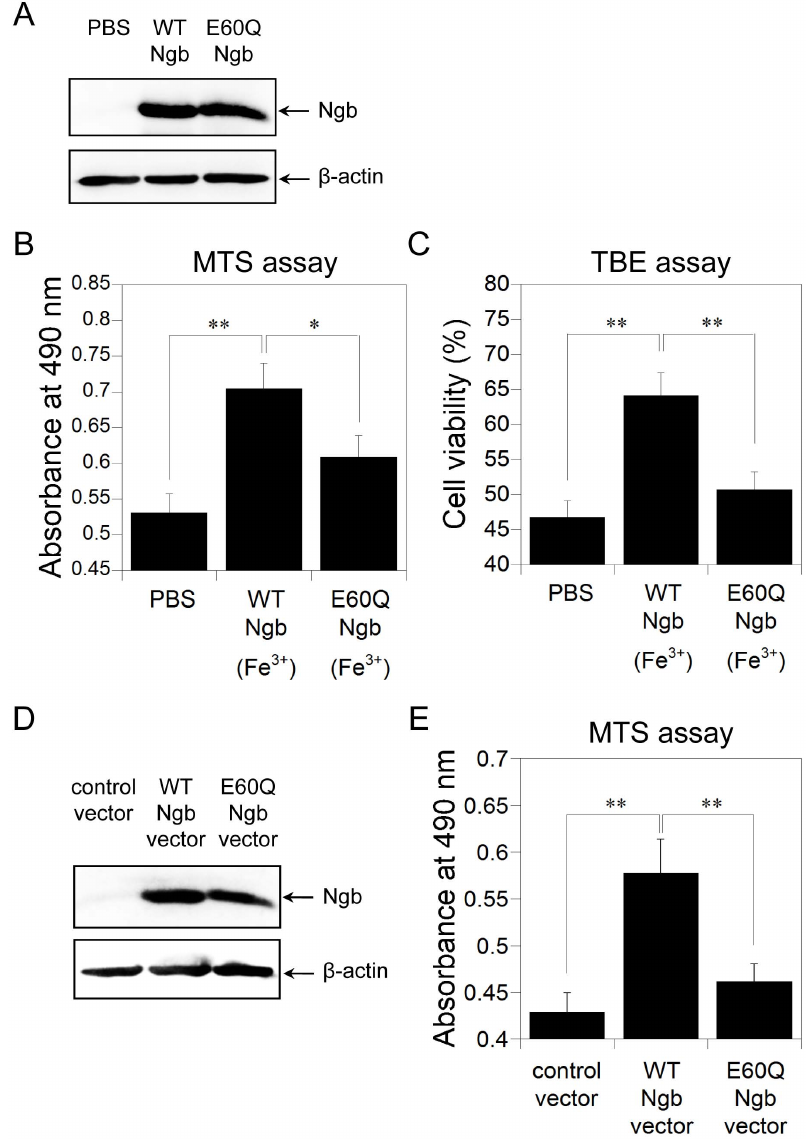
Figure 4. Effects of human WT Ngb or E60Q Ngb on neuroprotective activities. (A) Western blot analyses of SH-SY5Y cell lysates after protein transduction. PBS, human WT Ngb or human E60Q Ngb was applied to differentiated SH-SY5Y cells with Chariot. The cells were then incubated for 3 h. Cell lysates were analyzed on 15.0% or 12.5% SDS/PAGE and by Western blot analyses using rabbit anti-Ngb polyclonal antibody or mouse anti- b -actin monoclonal antibody, respectively. (B,C) Effect of the E60Q mutation in human Ngb on SH-SY5Y cell death caused by the in vitro OGD model of ischemia. Human WT or E60Q Ngb was transfected into differentiated cells using Chariot. Following OGD/recovery, cell viability was measured by MTS (B) and TBE assays (C). All data are expressed as means 6 SEM from three independent experiments, each performed in triplicate. Data were analyzed by one-way ANOVA followed by Tukey-Kramer post hoc tests. *P , 0.05, **P , 0.01. (D) Western blot analyses of SH-SY5Y cell lysates after transfection. Control vector, human WT or E60Q Ngb expression vector was transfected into differentiated SH-SY5Y cells with Lipofectamine. The cells were then incubated for 24 h. Cell lysates were analyzed on 15.0% or 12.5% SDS/PAGE and by Western blot analyses using rabbit anti-Ngb polyclonal antibody or mouse anti- b -actin monoclonal antibody, respectively. (E) Effect of the E60Q mutation in human Ngb on SH- SY5Y cell death caused by hydrogen peroxide. Differentiated SH-SY5Y cells transfected with control vector, human WT or E60Q HNgb expression vector with Lipofectamine were treated with hydrogen peroxide, and cell viability was measured by MTS assay. All data are expressed as means 6 SEM from six independent experiments, each carried out in triplicate. Data were analyzed by one-way ANOVA followed by Tukey-Kramer post hoc tests. **P ,